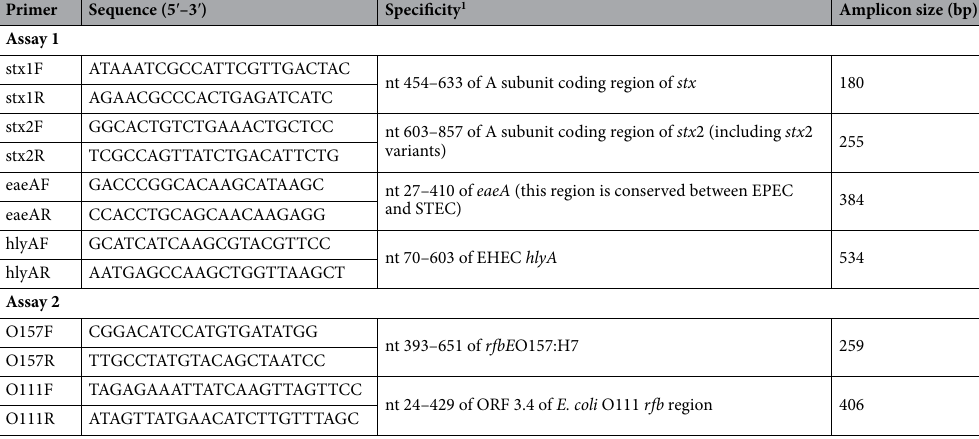
Table 1. The PCR primers. 1 nt nucleotide, ORF open reading frame 29